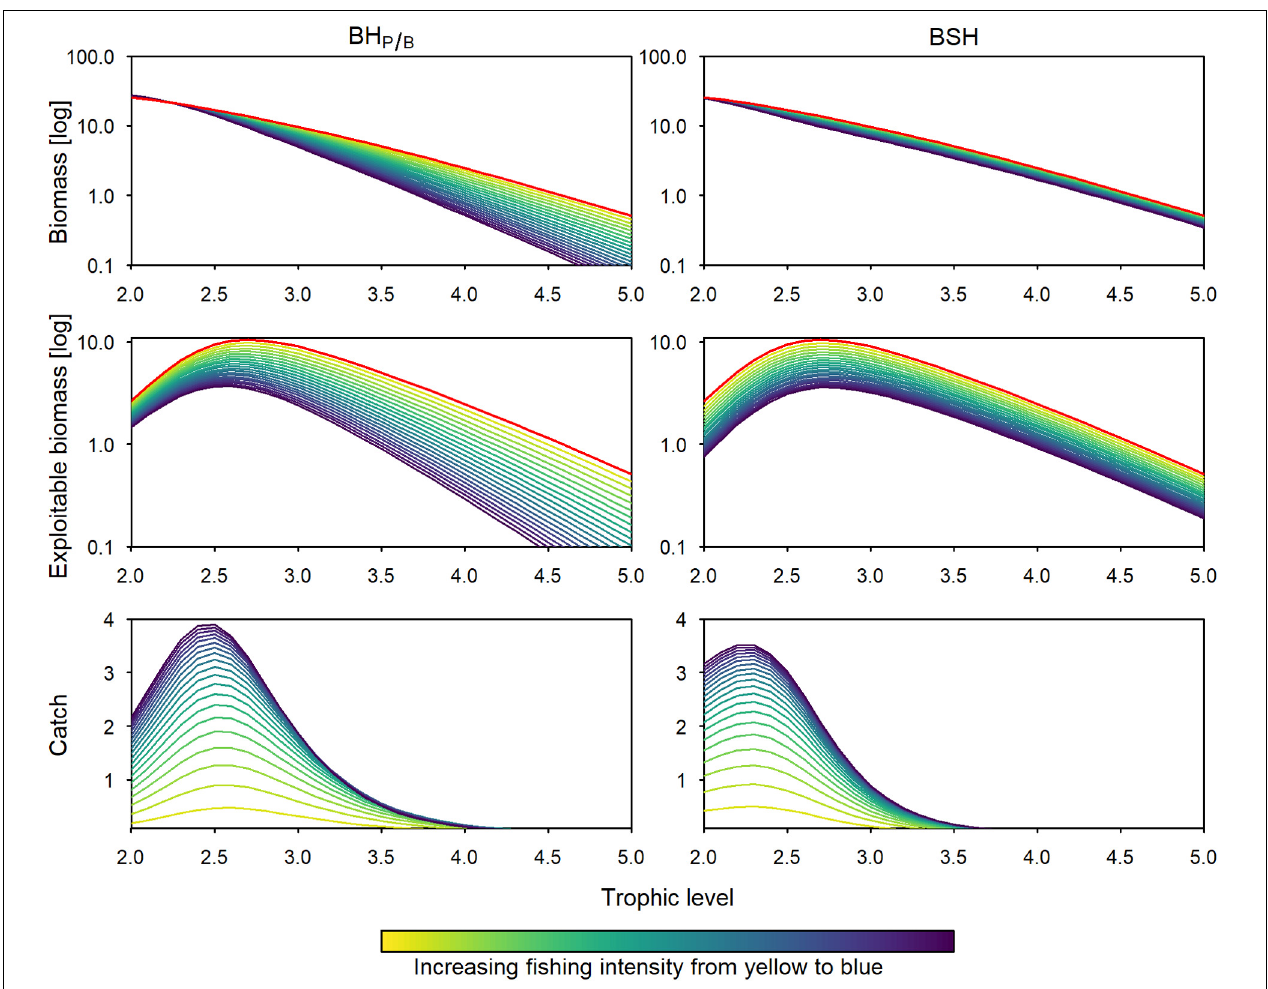
FIGURE 4 | Total and exploitable biomass (log transformed), and catch trophic spectrum, under BH P / B ( left panels) and BSH ( right panels) assuming limited exploitability of lower and intermediate trophic levels. Colors as in Figure 3